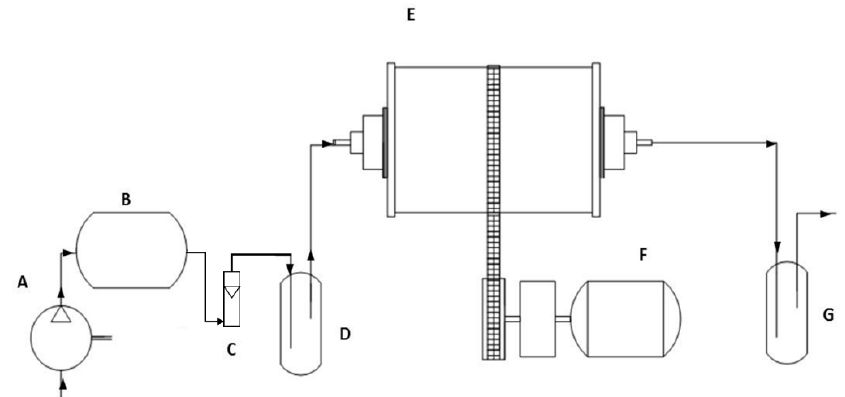
Figure 1. Flow chart of the designed and custom-made rotary drum bioreactor (RDB) for the bioremediation of mercury-polluted agricultural soils. ( A ) Air compressor; ( B ) Air accumulator balloon; ( C ) Air rotameter; ( D ) Air humidifier; ( E ) RDB; ( F ) Rotation mechanism; ( G ) Mercury gas oxidizing trap containing HNO 3 (1 M). Arrows indicate gas flow during operation. Hg (II) in polluted soil is reduced to Hg (0) gaseous by C. metallidurans MSR33 in the RDB ( E ). Gas is displaced from the RDB by air injection ( A – D ). Gaseous Hg (0) is captured by gas stripping in an oxidizing trap, where Hg (0) is oxidized to Hg (II) ( G